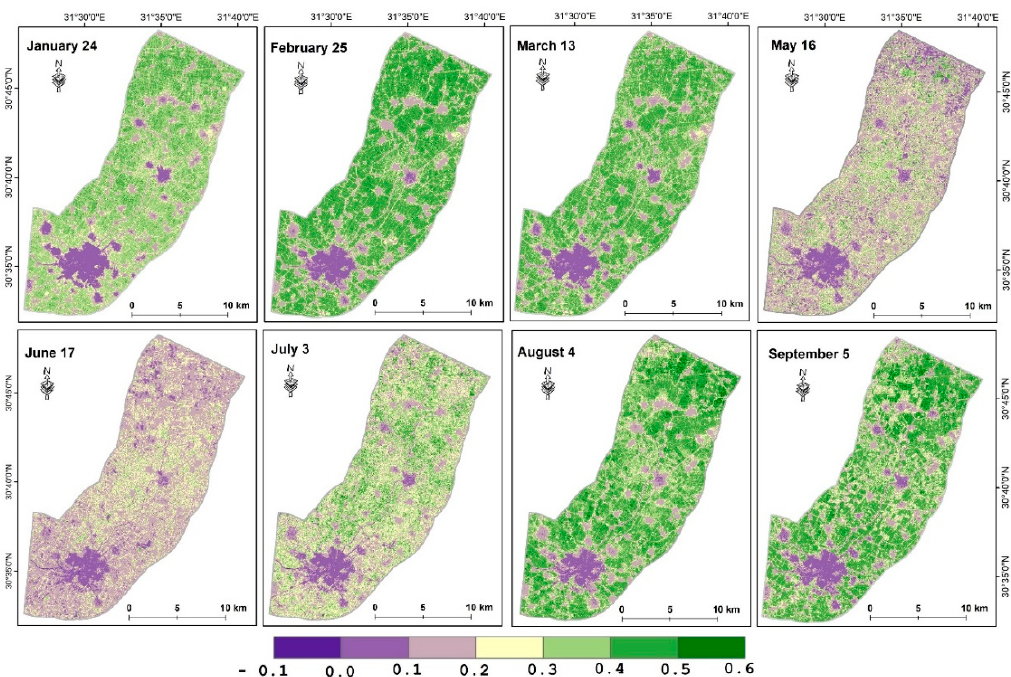
Figure 3. The variation in the normalized difference vegetation index (NDVI) over eight months during 2019.